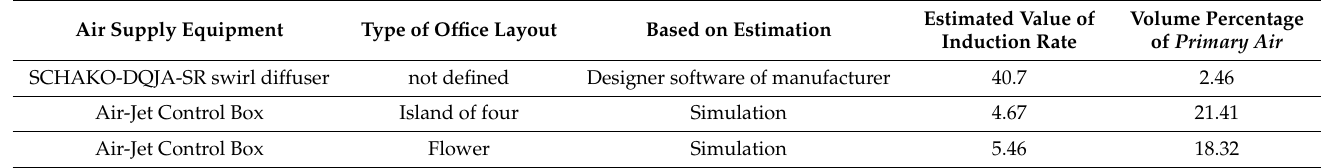
Table 5. Induction rate and primary air